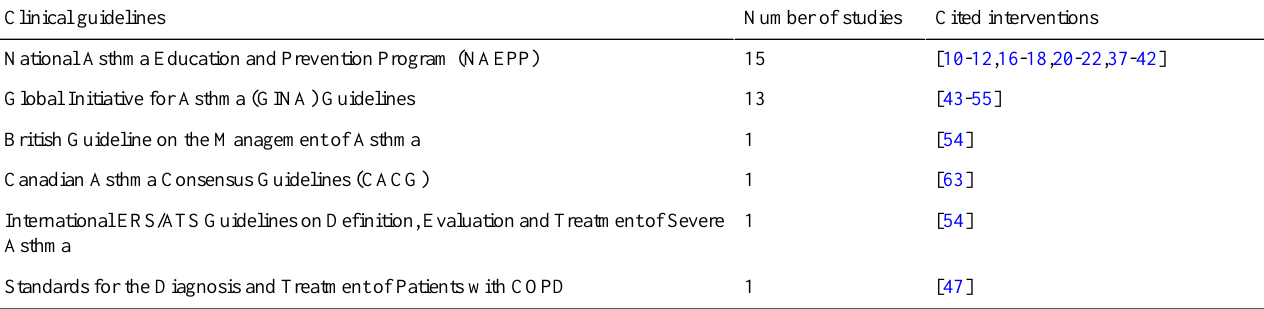
Table 3. Applied clinical guidelines of the 85 reviewed Internet-based asthma